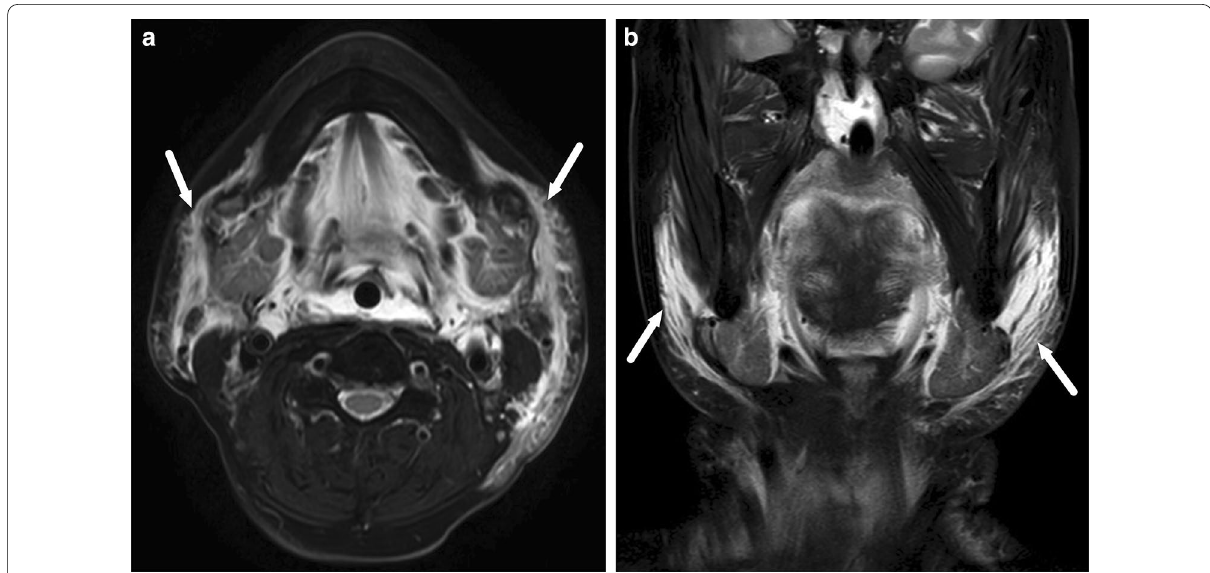
Fig. 38 Patient with acute angioedema shows widespread edema in the neck soft tissues on axial ( a ) and coronal ( b ) fat-suppressed T2-weighted images (arrows), but no